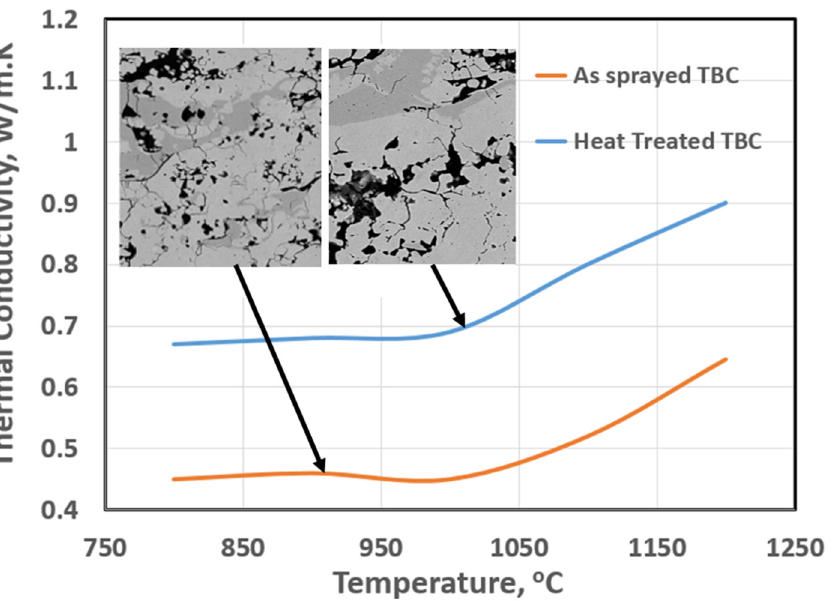
Figure 8. Thermal conductivity data of as-sprayed and thermally exposed material (at 1300 °C for 25 h) for a typical two-phase (t’+c) composite zirconia-based topcoat. 25 h) for a typical two-phase (t’+c) composite zirconia-based